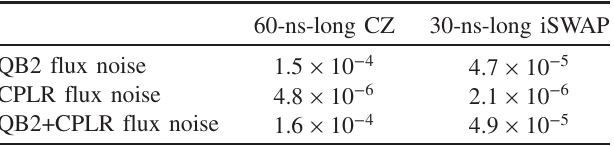
TABLE VIII. 1 =f α flux noise contributions to the average gate errors of a 60-ns-long CZ and a 30-ns-long iSWAP gate. Each flux noise contribution is computed by taking the difference between the gate errors in the presence and the absence of flux noise.